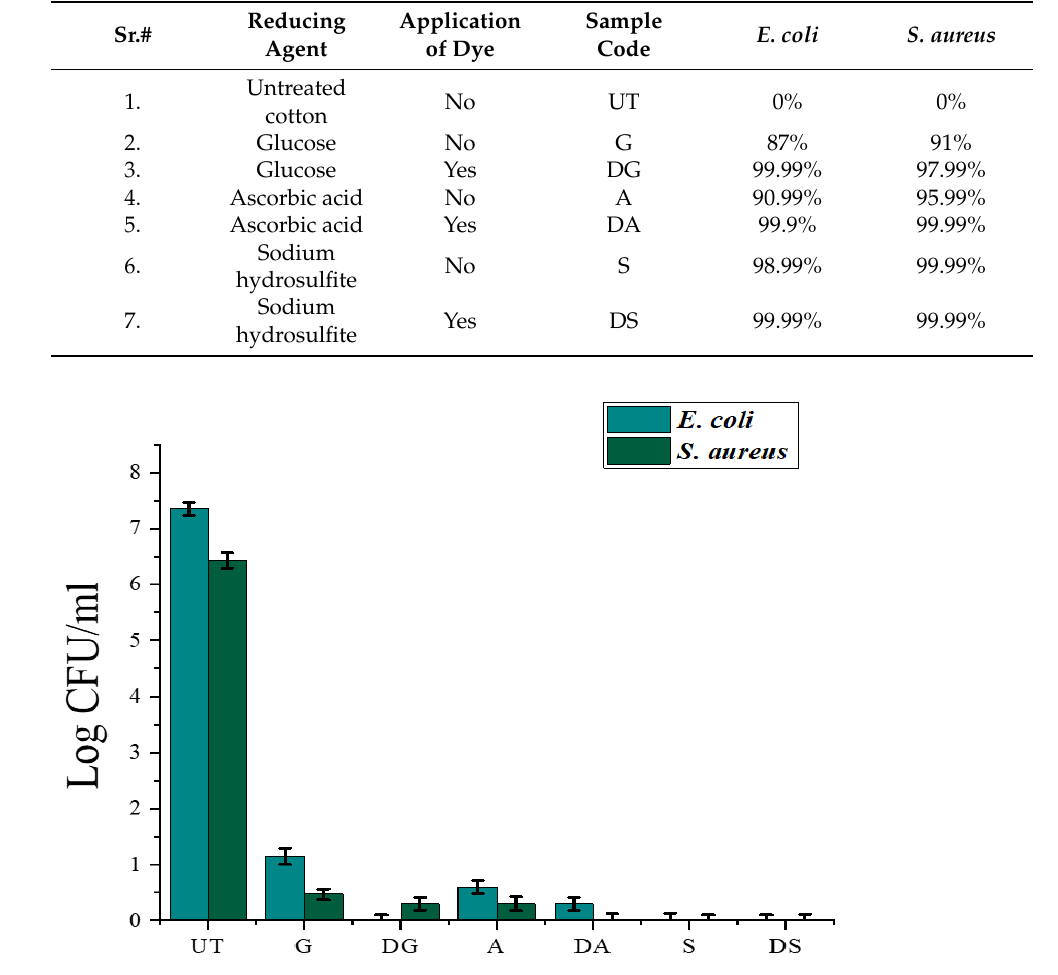
Table 7. The percentage reductions of developed samples against S. aureus and E. coli .